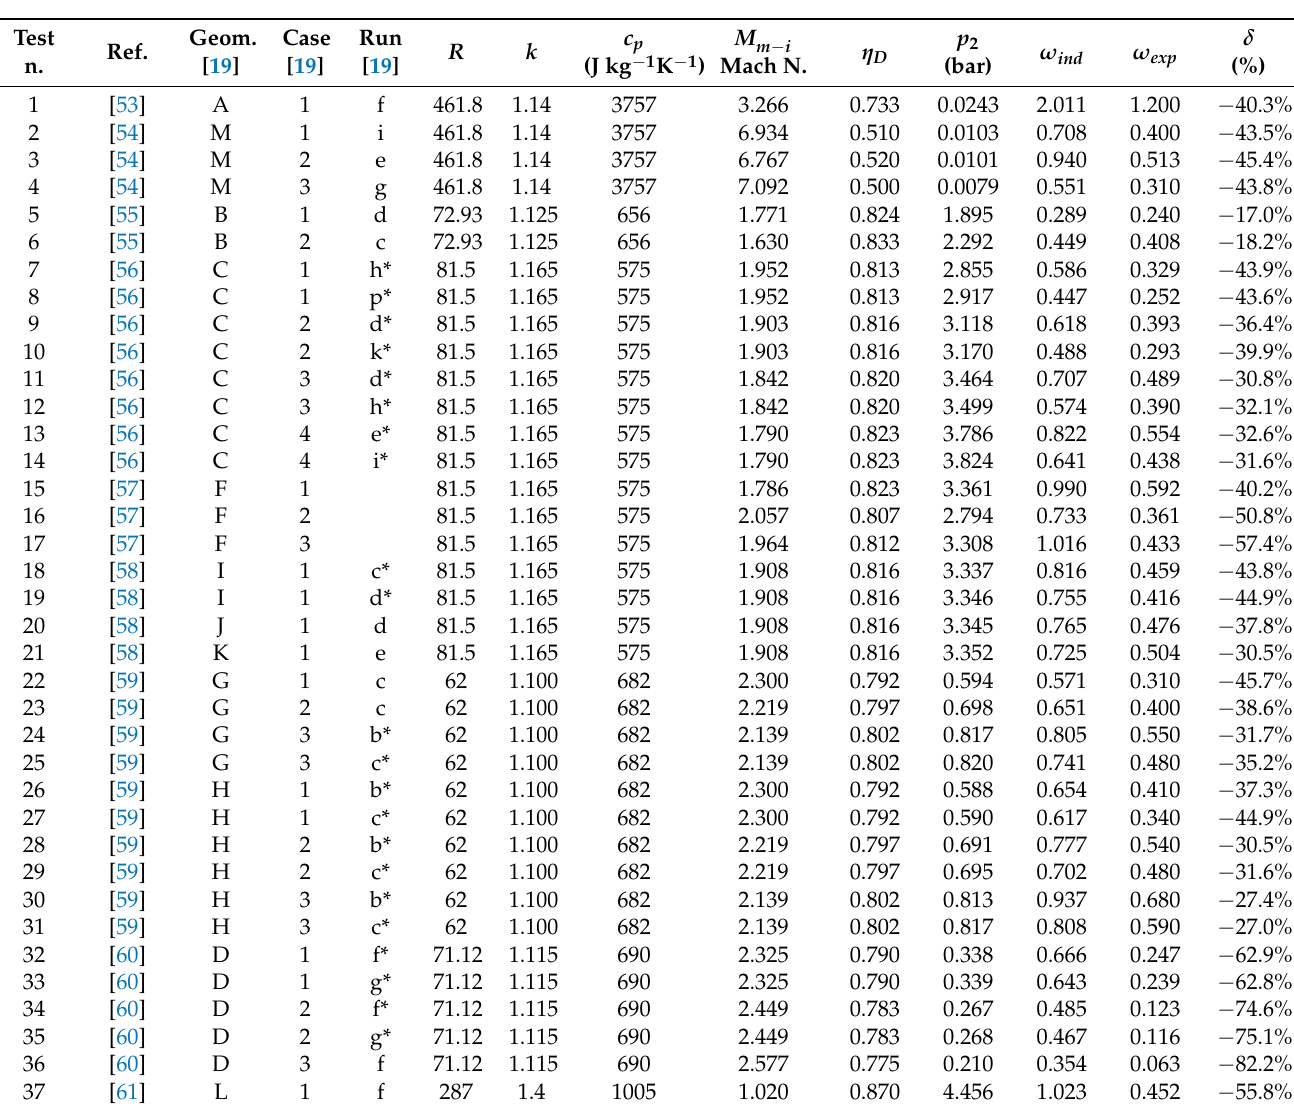
Table 5. Results of mathematical modelling applied to the first series of benchmark ejectors (Table 2), in order to determine the industrial entrainment ratio ω ind vs. the experimental one ω exp